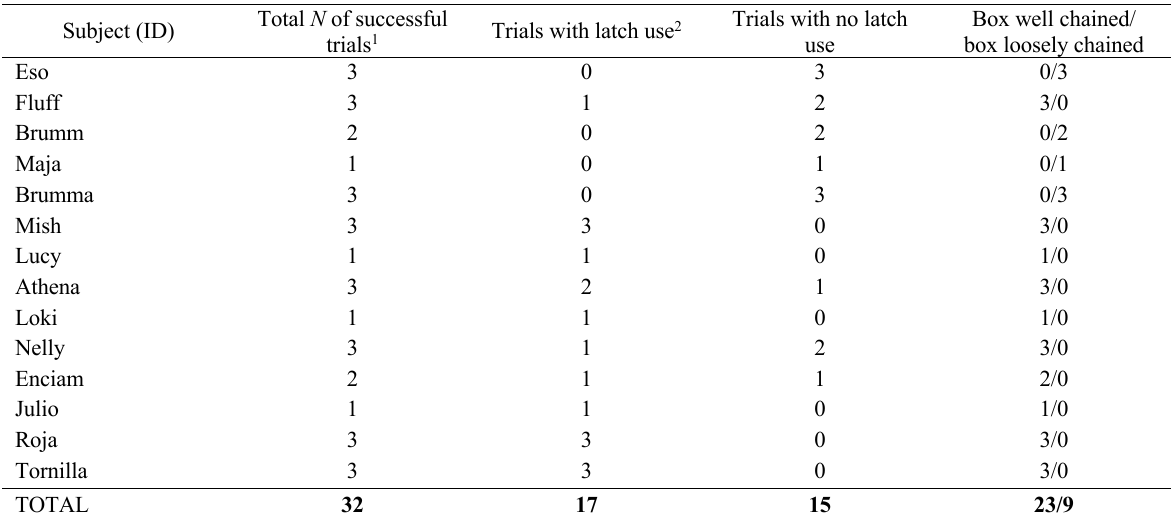
Results of the Puzzle Box Trials, Including How the Box Was Presented and Presence/Absence of Latch